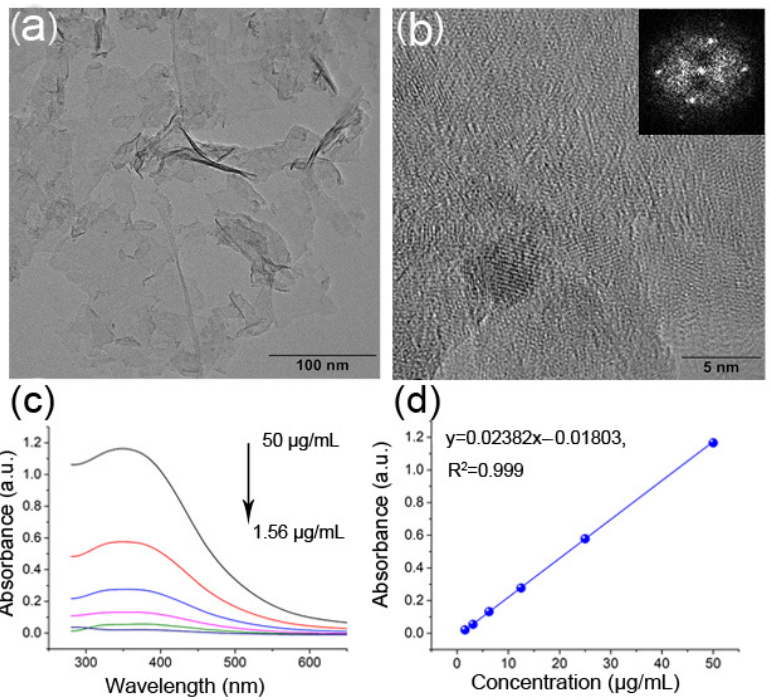
Figure 3. Characterization of MnO 2 NSs. TEM images ( a ) and HR-TEM image (Insert: Fourier diffractogram image) ( b ) of MnO 2 NSs; UV-Vis spectroscopy ( c ) and the linear relationship between Absorbance at 365 nm ( d ) versus 1.56–50 µ g/mL of MnO 2 NSs.